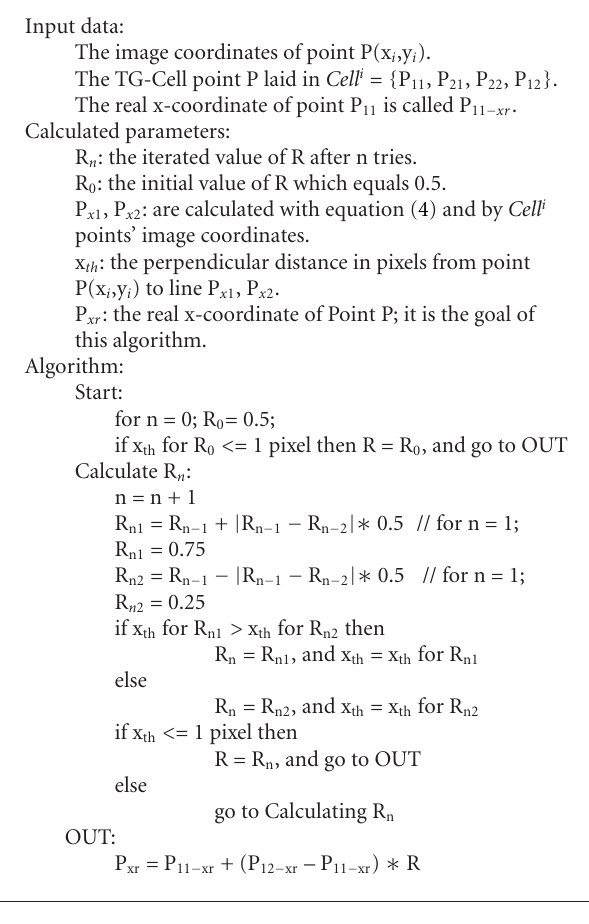
Algorithm 3: Transformation grid (TG) algorithm.